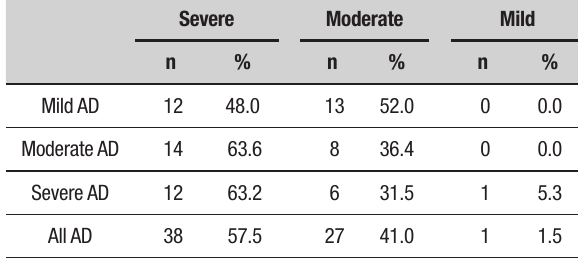
Table 3. Distribution of stress levels of family caregivers according to SRQ. 7 São Carlos-SP, Brazil. 2015.